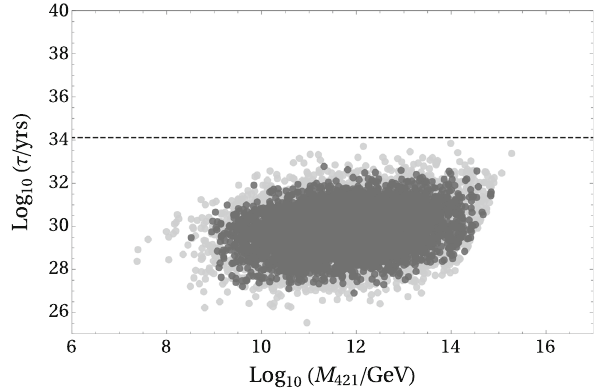
× SU ( 2 ) × SU ( 2 ) × C L R , 2 ] . 20